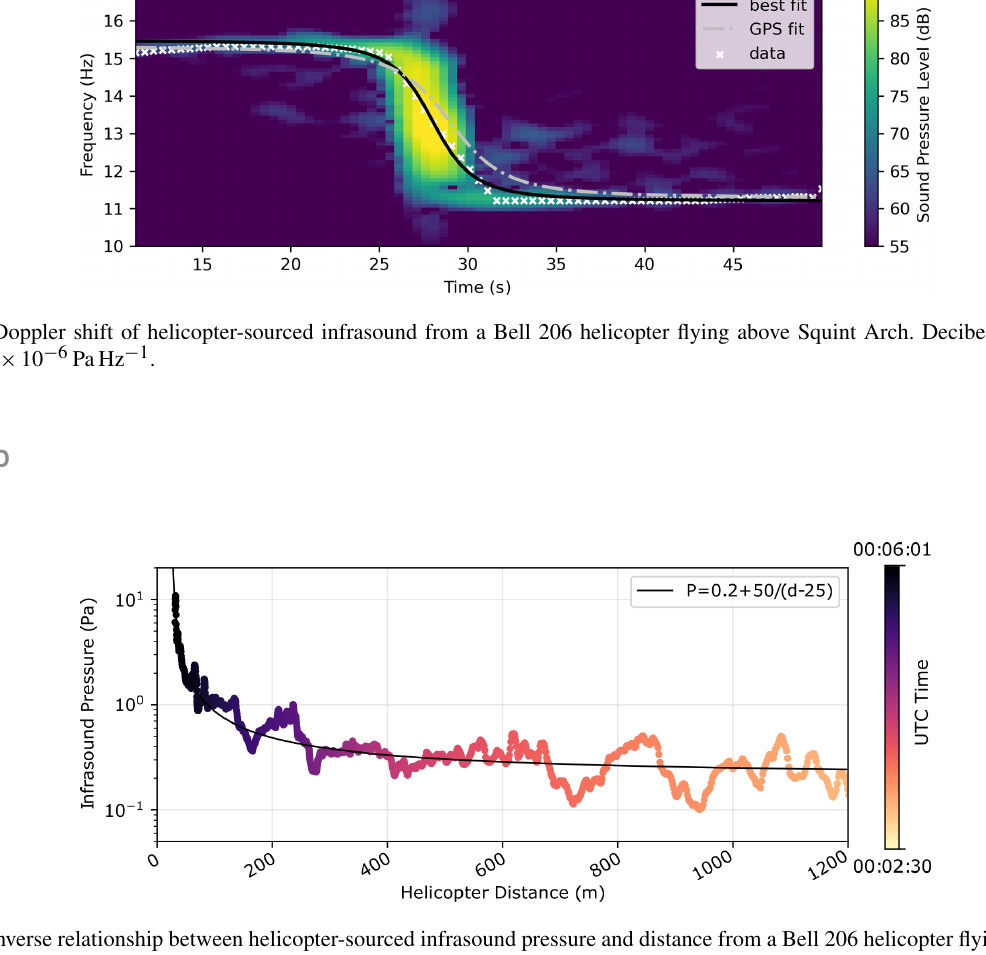
Figure D1. Inverse relationship between helicopter-sourced infrasound pressure and distance from a Bell 206 helicopter flying above Squint Arch. Data are filtered between 2 and